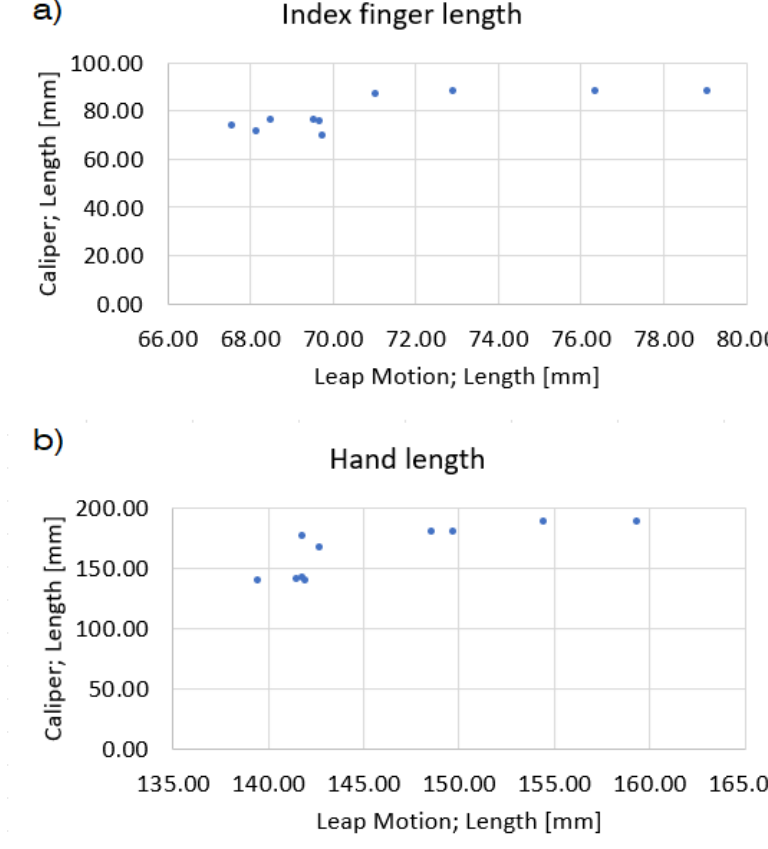
Figure 11. Results correlation of measurements via Leap Motion and Caliper for: ( a ) index finger length, ( b ) hand length.